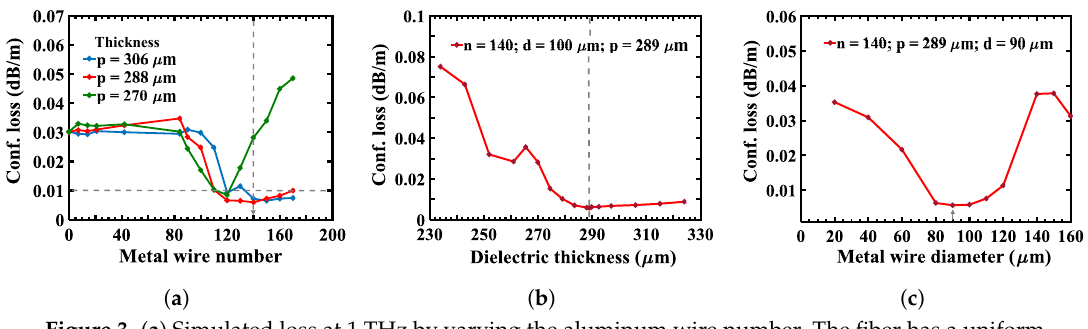
Figure 3. ( a ) Simulated loss at 1 THz by varying the aluminum wire number. The fiber has a uniform wire diameter d = 100 µ m for thickness between the internal side of the metal wire and the inner dielectric cladding layer of p = 306 µ m, 288 µ m, and 270 µ m. Simulated loss at 1 THz by varying ( b ) thickness between the internal side of the metal wire and the inner dielectric cladding layer p ; ( c ) the aluminum wire diameter d